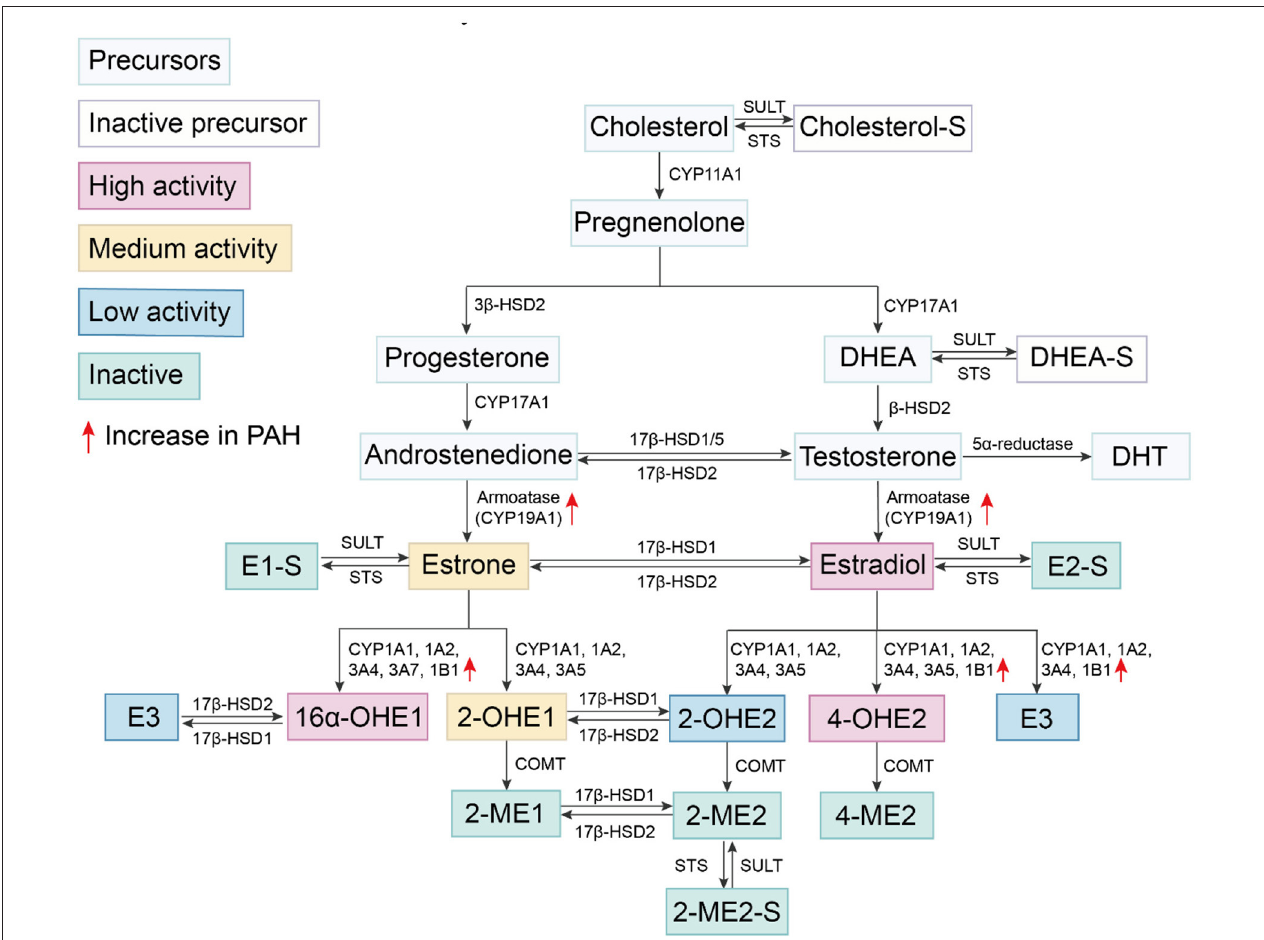
FIGURE 1 | Estrogen synthesis and metabolism. Cholesterol is catalyzed by the cytochrome P450 enzyme and undergoes several conversions to become DHEA. DHEA is converted to testosterone under the catalysis of different β -HSDs. Androstenedione and testosterone are converted into estrone and E2 by CYP19A1, respectively. E2 is oxidized on carbon at multiple positions, including oxidation at the C17 position by 17 β -HSD responsible for the reversible conversion between E1 and E2. Other oxidation sites include those at C2, C4, and C16 positions and produce different metabolites via varying cytochrome P450 enzyme. E1, E2, estrogen precursors and some metabolites can be combined with sulfonate groups by SULT to convert them into sulfuric steroids. Sulfation of steroids can be converted into active forms by STS.